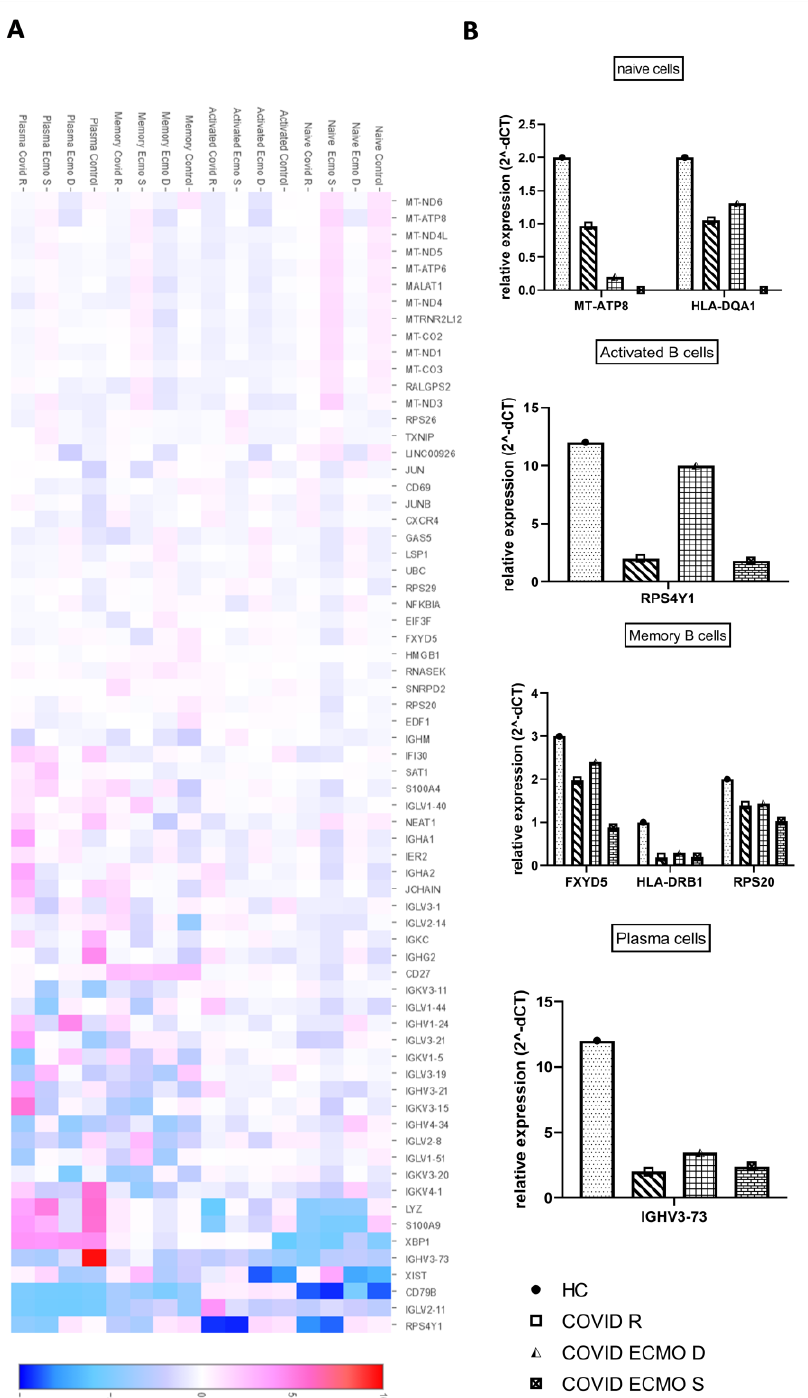
Figure 3. Features of B cell subpopulations. ( A ) Heat map representation of differentially expressed genes of B cell subpopulations (naïve cells, activated B cells, memory B cells, and plasma cells) of the COVID ECMO S, COVID ECMO D, COVID R, and healthy control. Genes with a maximum